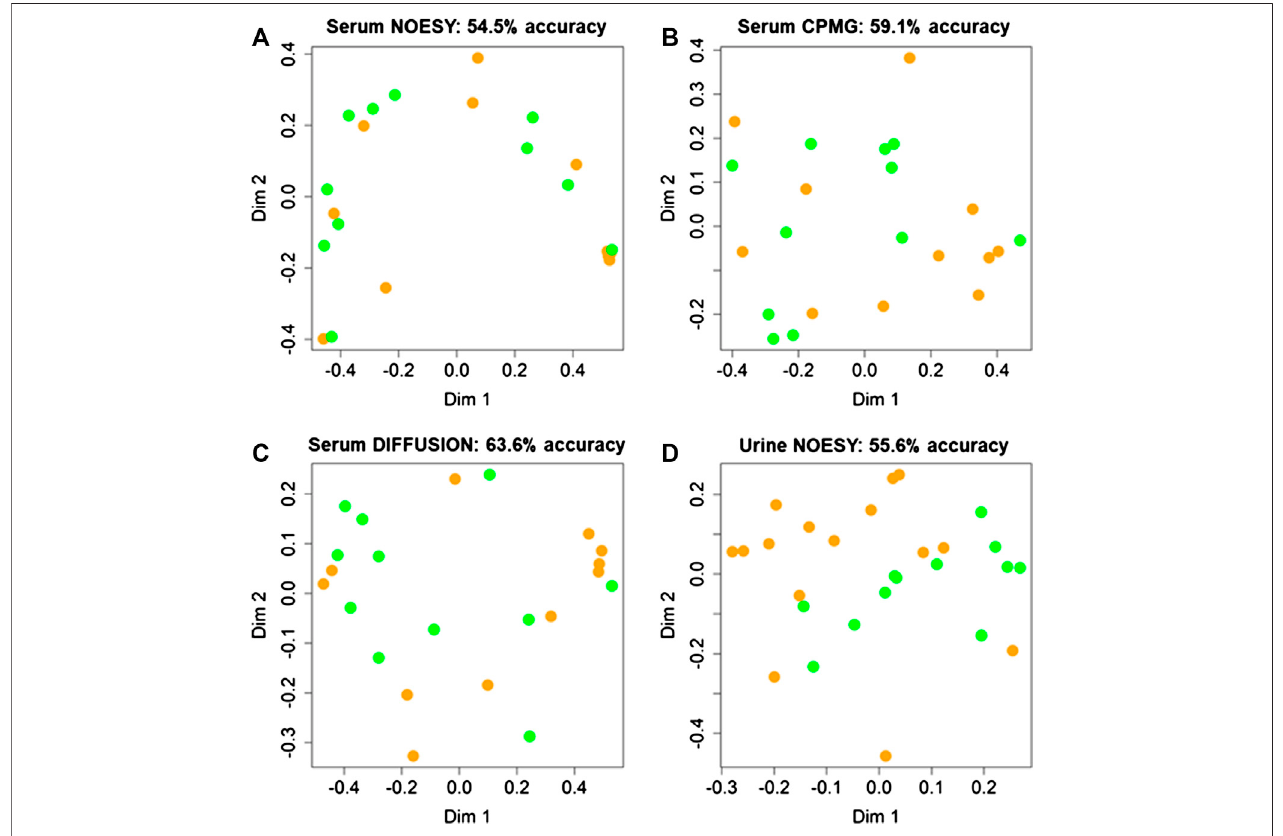
FIGURE2| Confusionmatricesandscoreplotsofthe fi rsttwoprincipalcomponentsoftheRandomForestmodelsdiscriminatingpatientswitherectiledisfunction inducedbyorganiccauses(green)andthoseforwhomthediseasewasrelatedbyothercauses(orange)calculatedontheNMRspectraacquired: (A) serumNOESY; (B) serum CPMG; (C) serum DIFFUSION; (D) urine